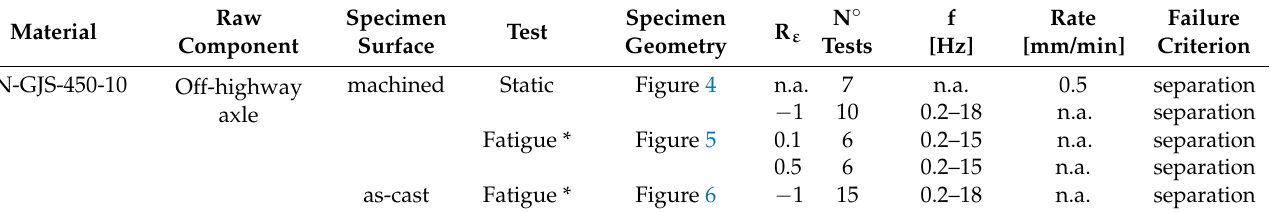
Table 3. Summary of static and fatigue tests performed on specimens made of nodular cast irons. Raw Material